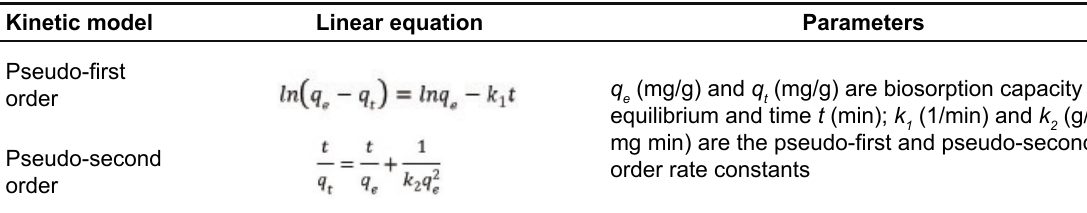
Table 3. Linear equations of Kinetic